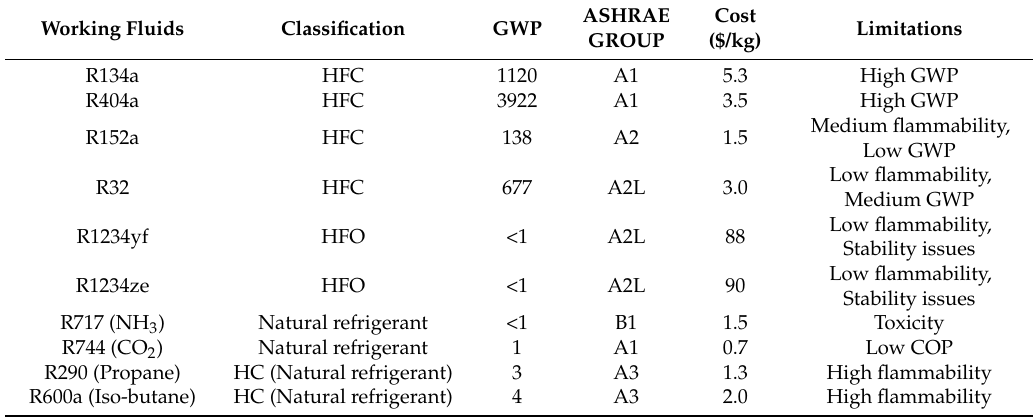
Table 1. Refrigerants and their characteristics [7–9]. GWP: global warming potential; COP: coefficient of